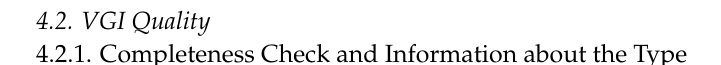
Table 2. Percentage of omission for buildings in “Type” and geodetic reference system for each city. City Percentage of Omission in “Type” for Buildings Geodetic Reference System 96 GGRS87 42 ETRS89/LCC Germany (E-N) 94 RGF93/Lambert-93 42 Amersfoort/RD